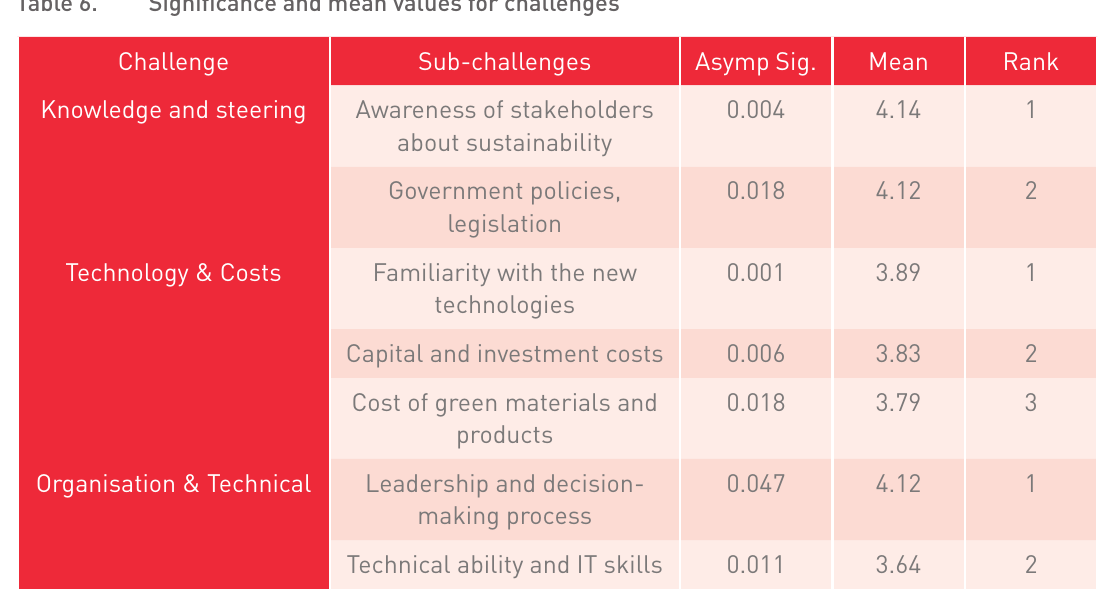
Table 6. Significance and mean values for challenges